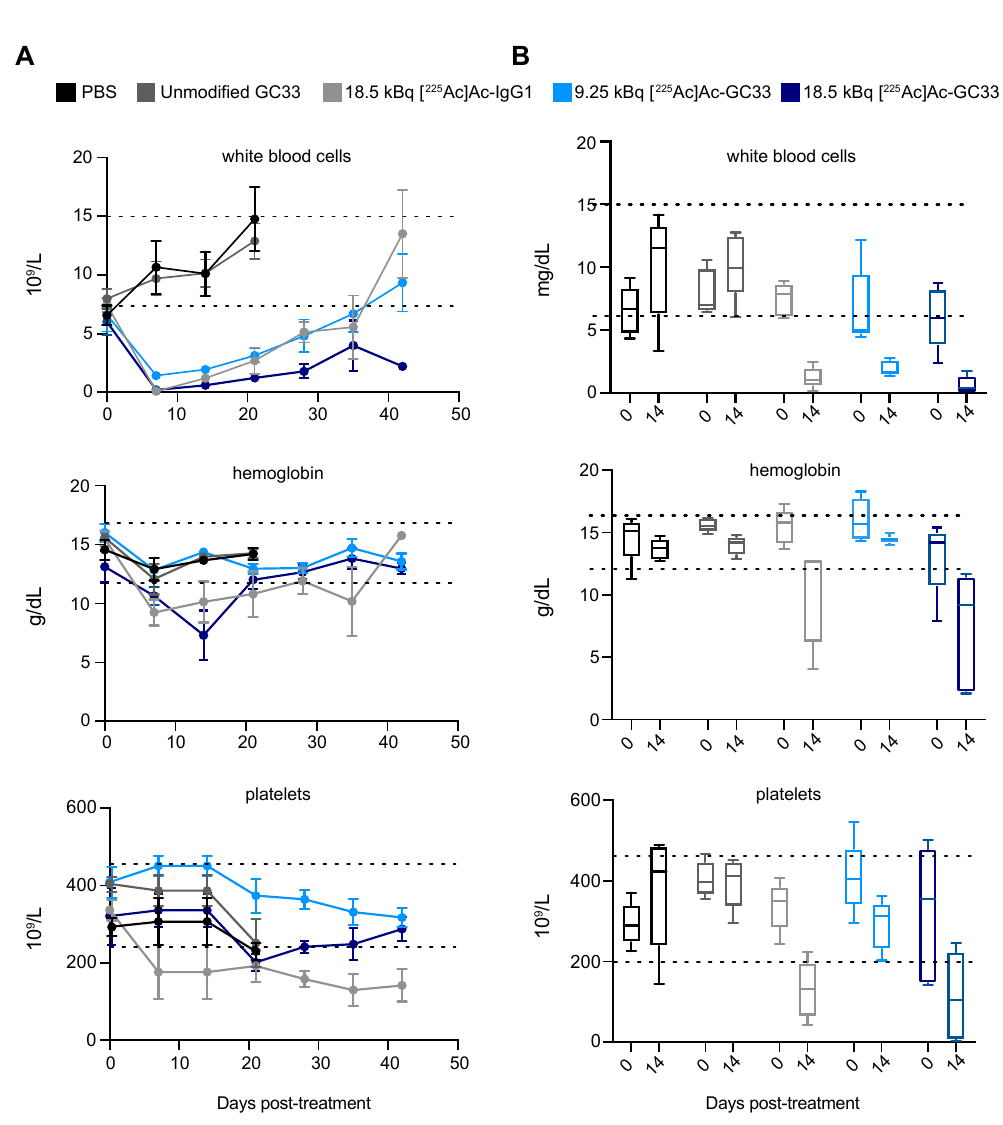
Figure 4. Complete blood count (CBC) shows acute hematological toxicity and gradual recovery following treatment with 225 Ac-labeled radioconjugates. ( A ). White blood cell count, hemoglobin, and platelets were measured as part of CBC analysis of whole blood samples and plotted over time (mean ± SEM). Counts for all parameters drop dramatically 7 days p.i. for groups treated with either radioconjugate, followed by eventual recovery of majority of parameters to within normal range denoted by dotted lines ( n = 5). ( B ). Measurement of white blood cells, hemoglobin, and platelets from day 0 and day 14 p.i. were plotted on box-and-whisker plots and compared. Unlike other radioconjugate-treated groups, there was a less dramatic decrease in white blood cell count for the 9.25 kBq group hemoglobin and platelet counts remained in normal range for the duration of the study. Error bars represent the minimum and maximum values observed, the length of the box represents the range from the 25th to 75th percentile, and the horizontal line within the box represents the median. Dotted lines represent the normal range of values.